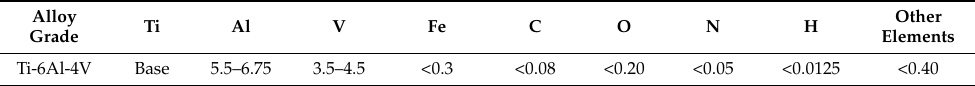
Table 1. Chemical composition of Ti-6Al-4V alloy according to AMS 4928. Alloy